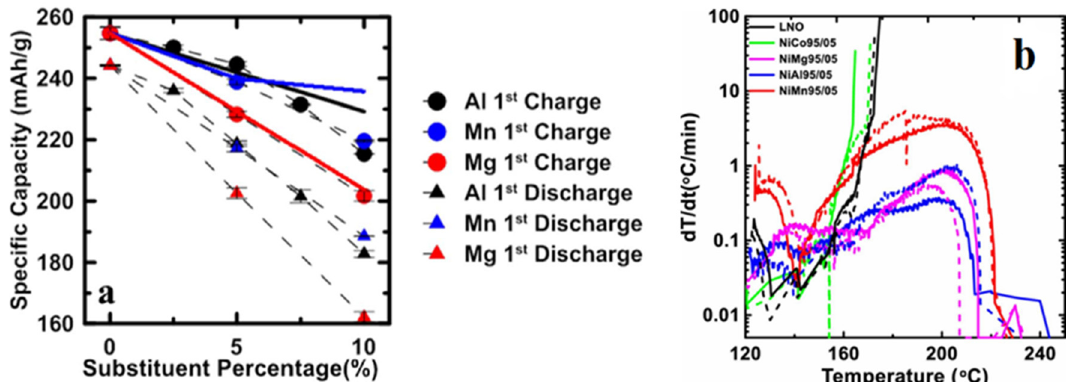
Figure 3. ( a ) Initial discharge capacity as a function of Al, Mn, and Mg percentage; and ( b ) self-heating rate of the delithiated LiNiO 2 and LiNi 0.95 M 0.05 O 2 (M=Co, Mg, Al or Mn) [8].